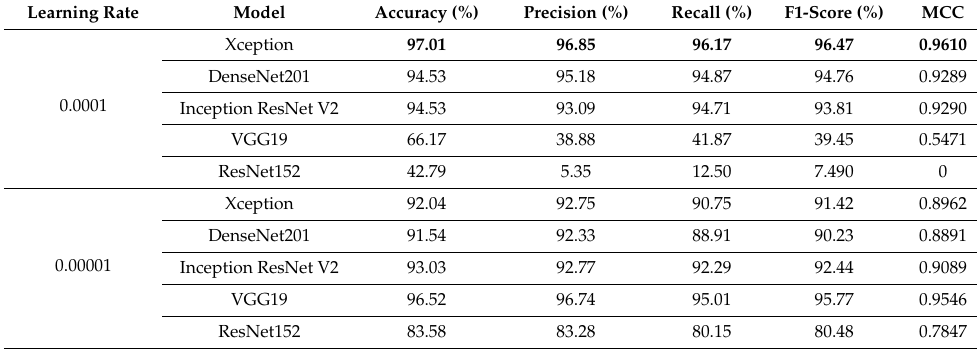
Table 10. Results of 40 × magnification factor in multi-classification mode; the highest results are shown in